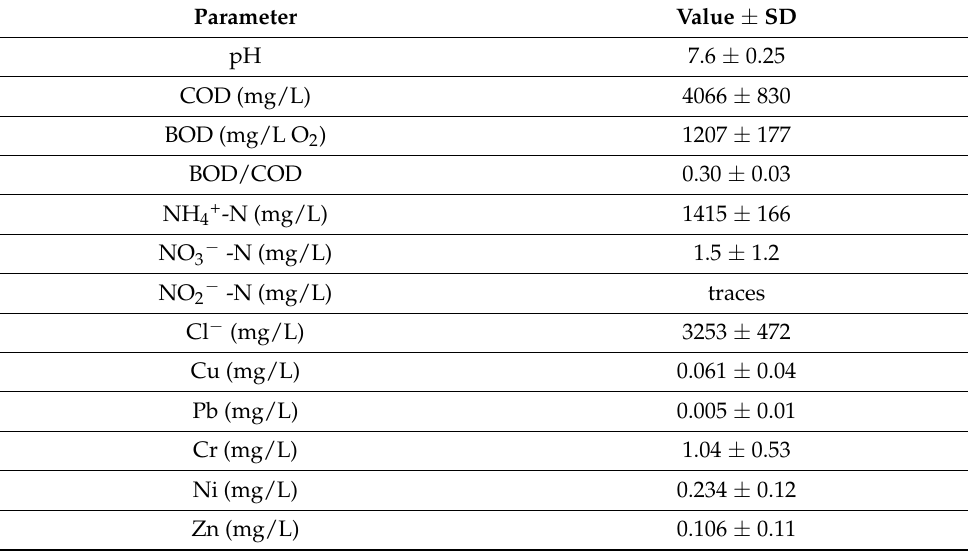
Table 1. Average composition of pre-treated leachates used in our